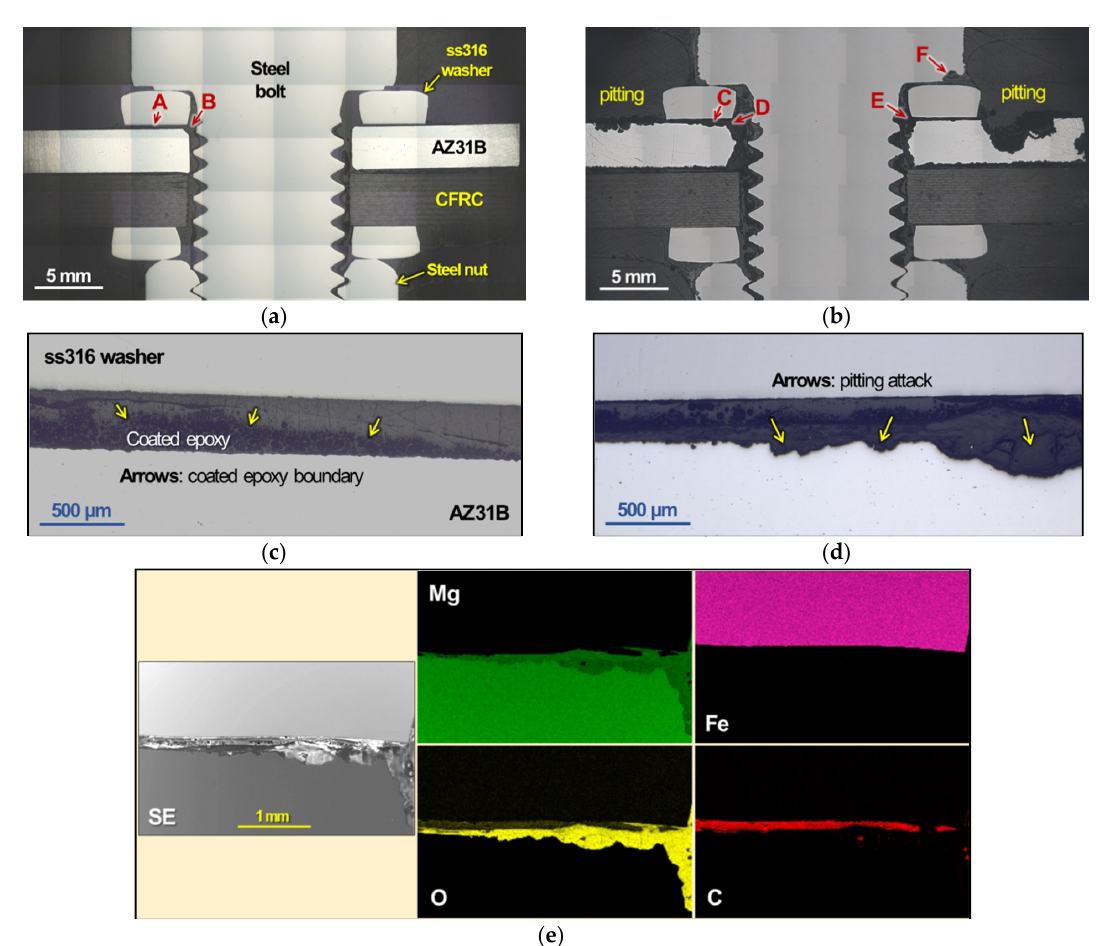
Figure 11. Light microscopy images of cross-sectioned polymer-insulated bolted joints ( a , c ) in as-joined condition and ( b , d ) after salt spray exposure for 1264 h. The local areas designated A in ( a ) and C in ( b ) are shown in a higher magnification in ( c , d ), respectively. An SEM image is presented in ( e ), and an EDS mapping analysis for a local area designated by C and D is presented in ( b ). SE indicates the secondary electron image mode. All EDS elemental maps were recorded using K-alpha characteristic X-ray of each element.